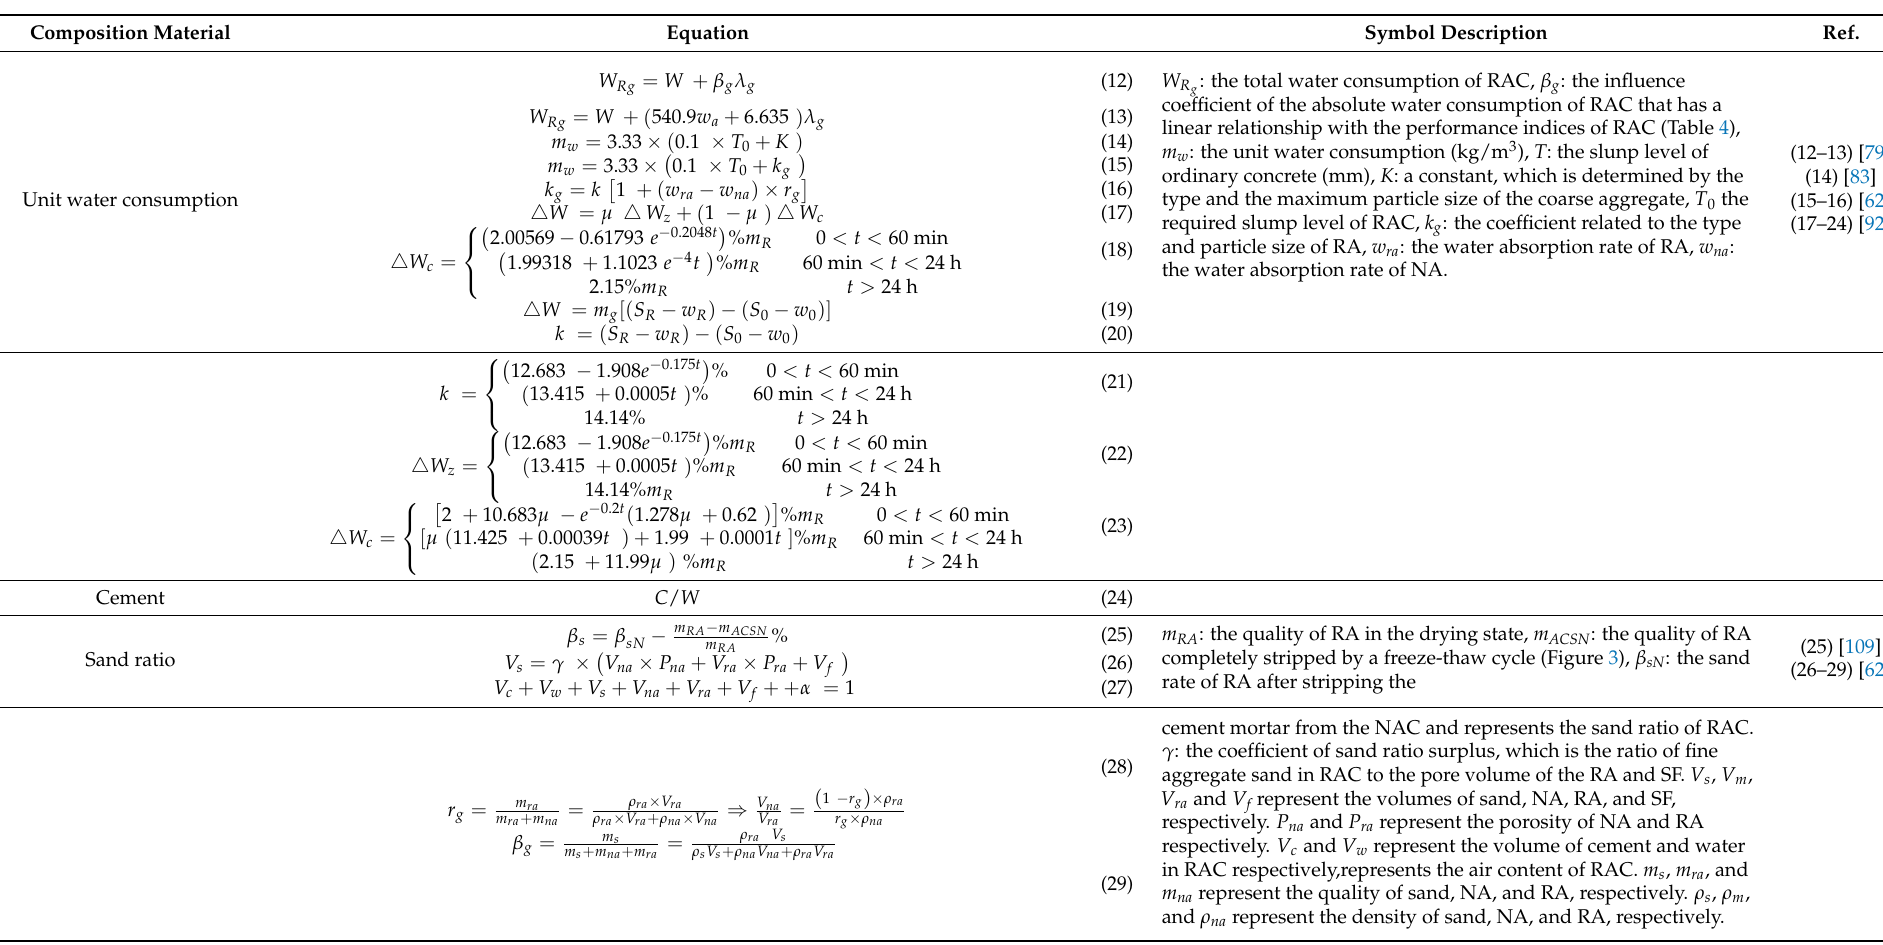
W R : the total water consumption of RAC, β g : the influence g coefficient of the absolute water consumption of RAC that has a linear relationship with the performance indices of RAC (Table 4), m w : the unit water consumption (kg/m 3 ), T : the slunp level of ordinary concrete (mm), K : a constant, which is determined by the type and the maximum particle size of the coarse aggregate, T 0 the required slump level of RAC, k g : the coefficient related to the type and particle size of RA, w ra : the water absorption rate of RA, w na : the water absorption rate of NA.